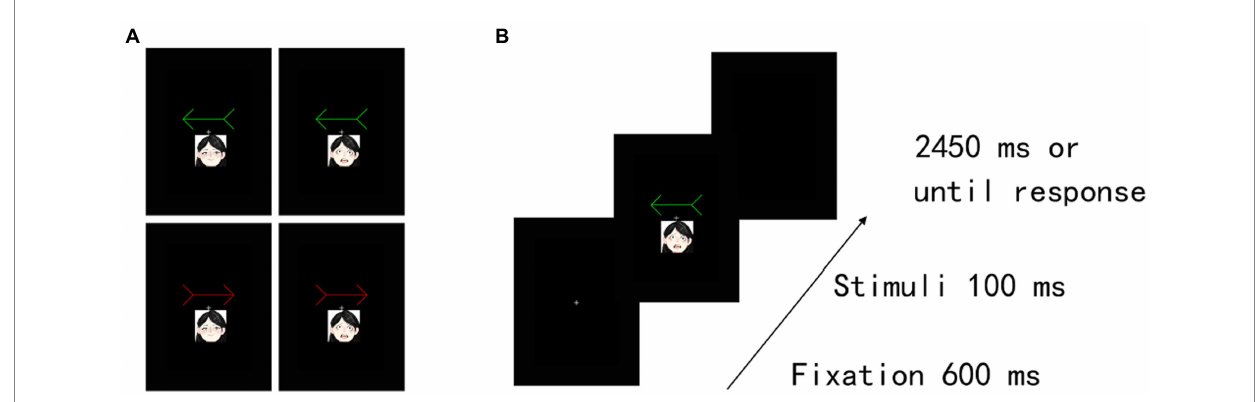
FIGURE 5 Experimental task structure and results in Experiment 2B. (A) Examples of happy-and fearful-arrow pair stimuli. (B) Illustration of stimuli presentation in the training task. The actual stimuli were photographs of emotional faces from the KDEF database of faces (see Lundqvist et al., 1998).